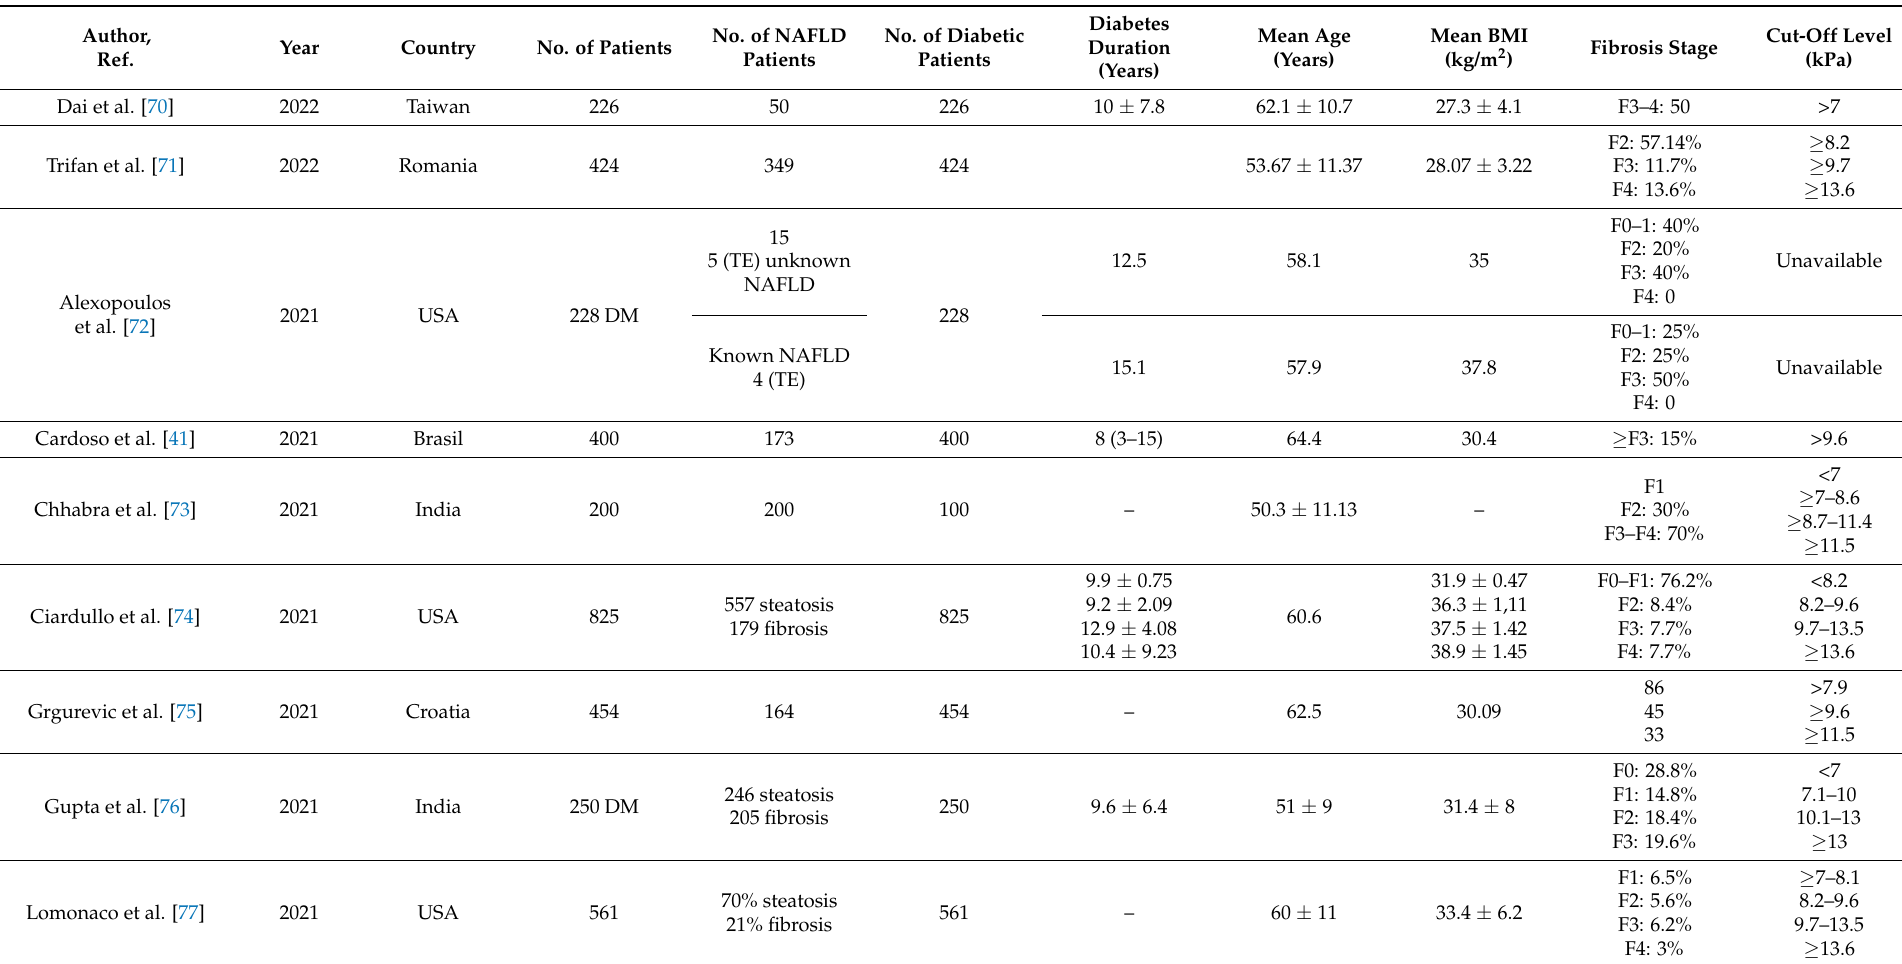
Table 1. Diagnostic performance and comparison of results for different fibrosis stages using LSM by transient elastography in patients with NAFLD and